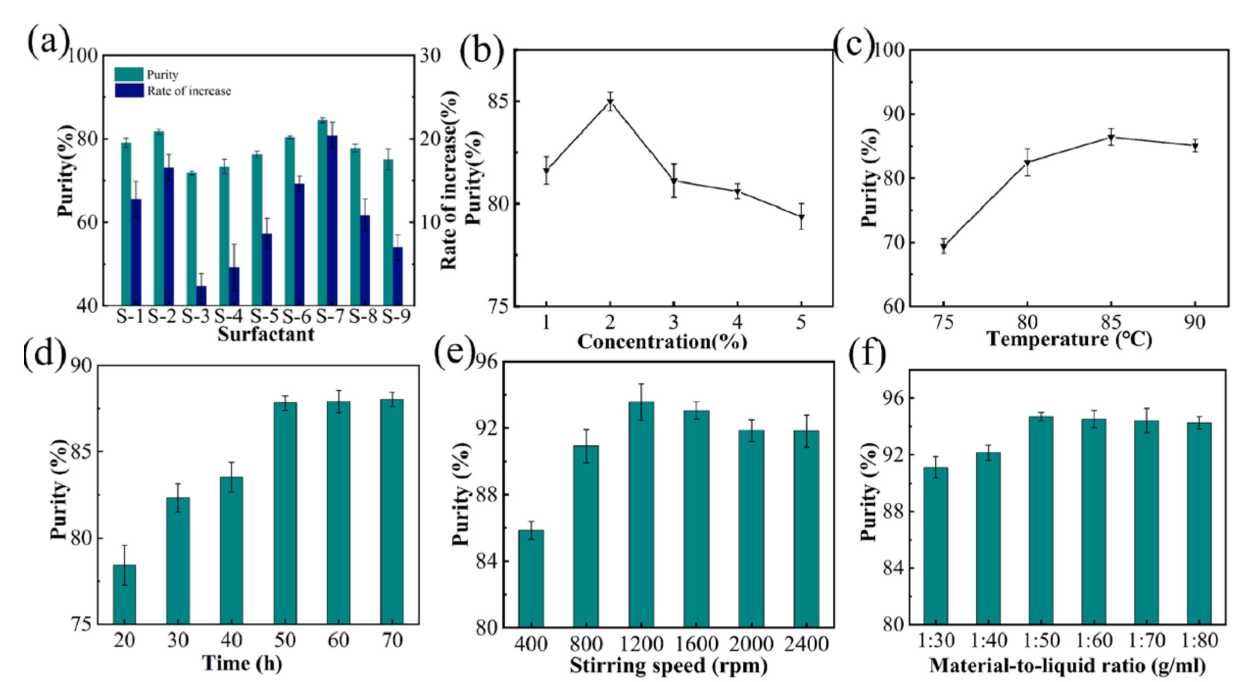
Figure 6. Effect of different dispersion conditions on gutta-percha purification. ( a ) surfactant species, ( b ) surfactant concentration, ( c ) temperature, ( d ) time, ( e ) stirring speed, ( f ) material-to-liquid